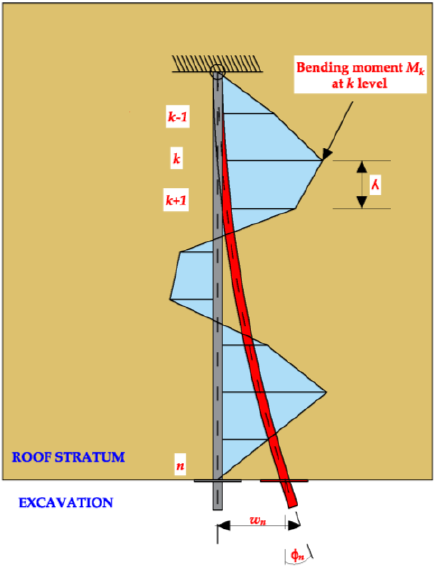
Figure 8. Rock bolt’s bar in a planned deformation state loaded with bending moments.